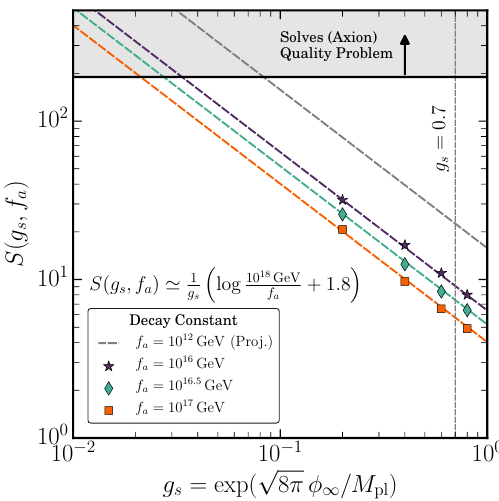
Figure 4 . U(1) wormhole action in an open string theory including the dynamics of the dilaton, the axion and the radial U(1) mode. We show the behaviour as a function of the string coupling √ g s = exp( 8 πφ ∞ /M pl ) and the symmetry breaking scale f a